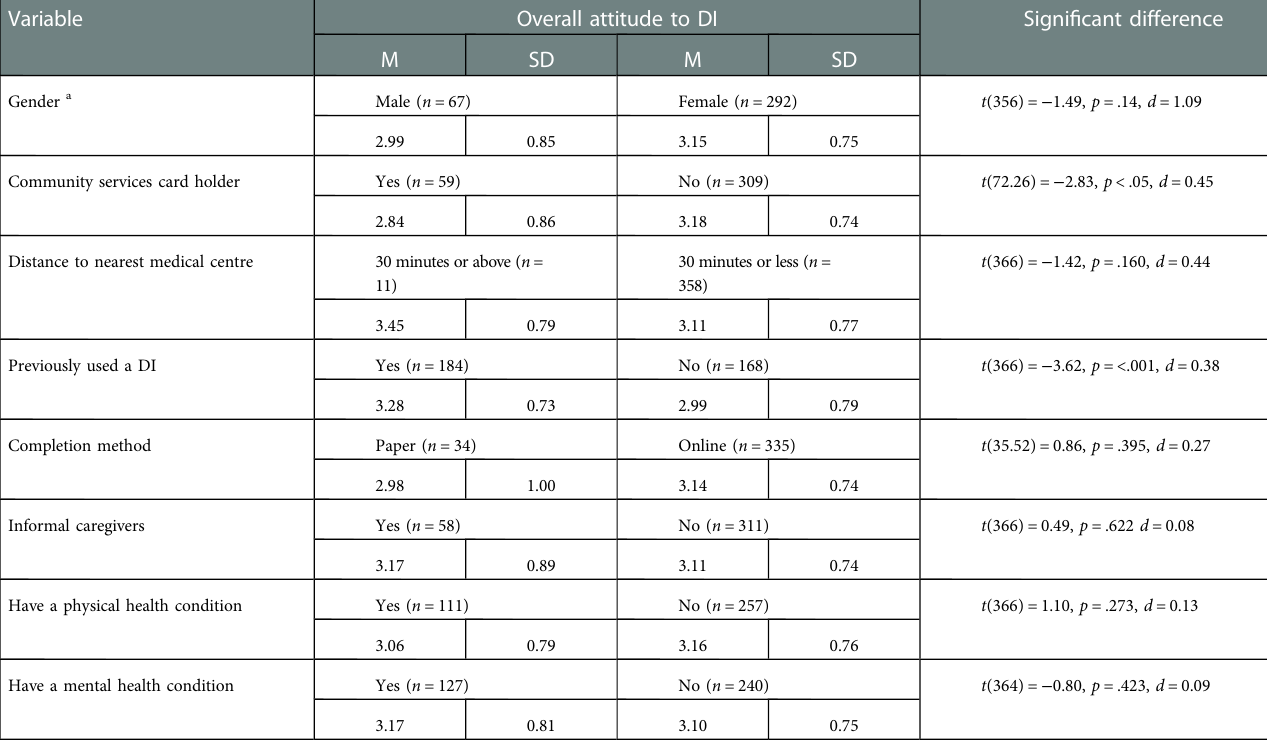
TABLE 3 Differences in average attitude towards DI for group membership